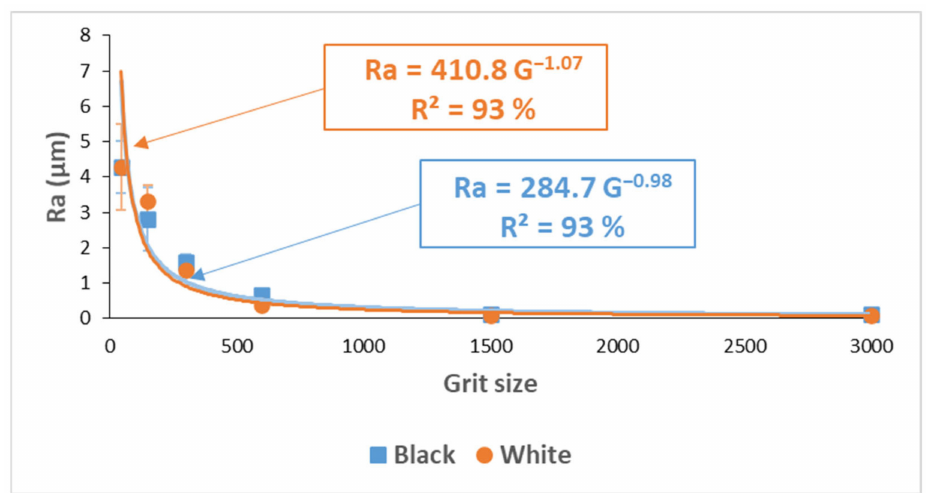
Figure 25. Roughness average Ra of white and black granite depending on grit size (Vs = 1500 rpm; f = 1000